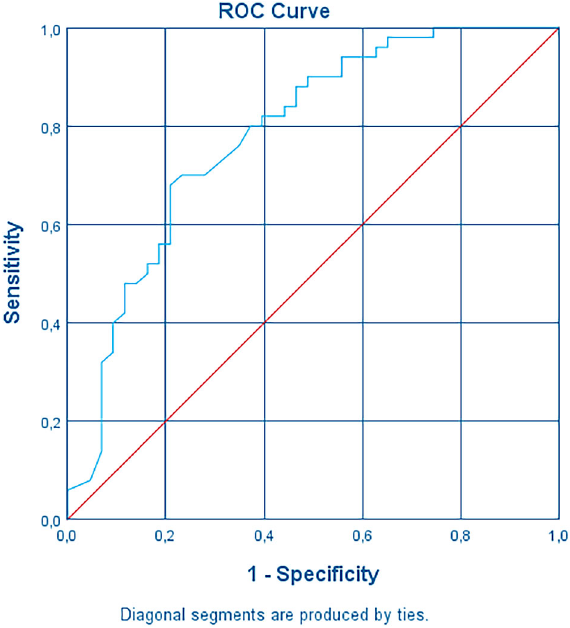
Figure 5. Receiving Operating Characteristic curve (ROC